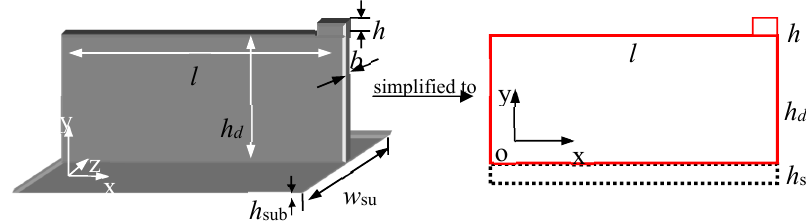
Figure 1. Schematic illustration of the simplified two-dimensional elastic plane.